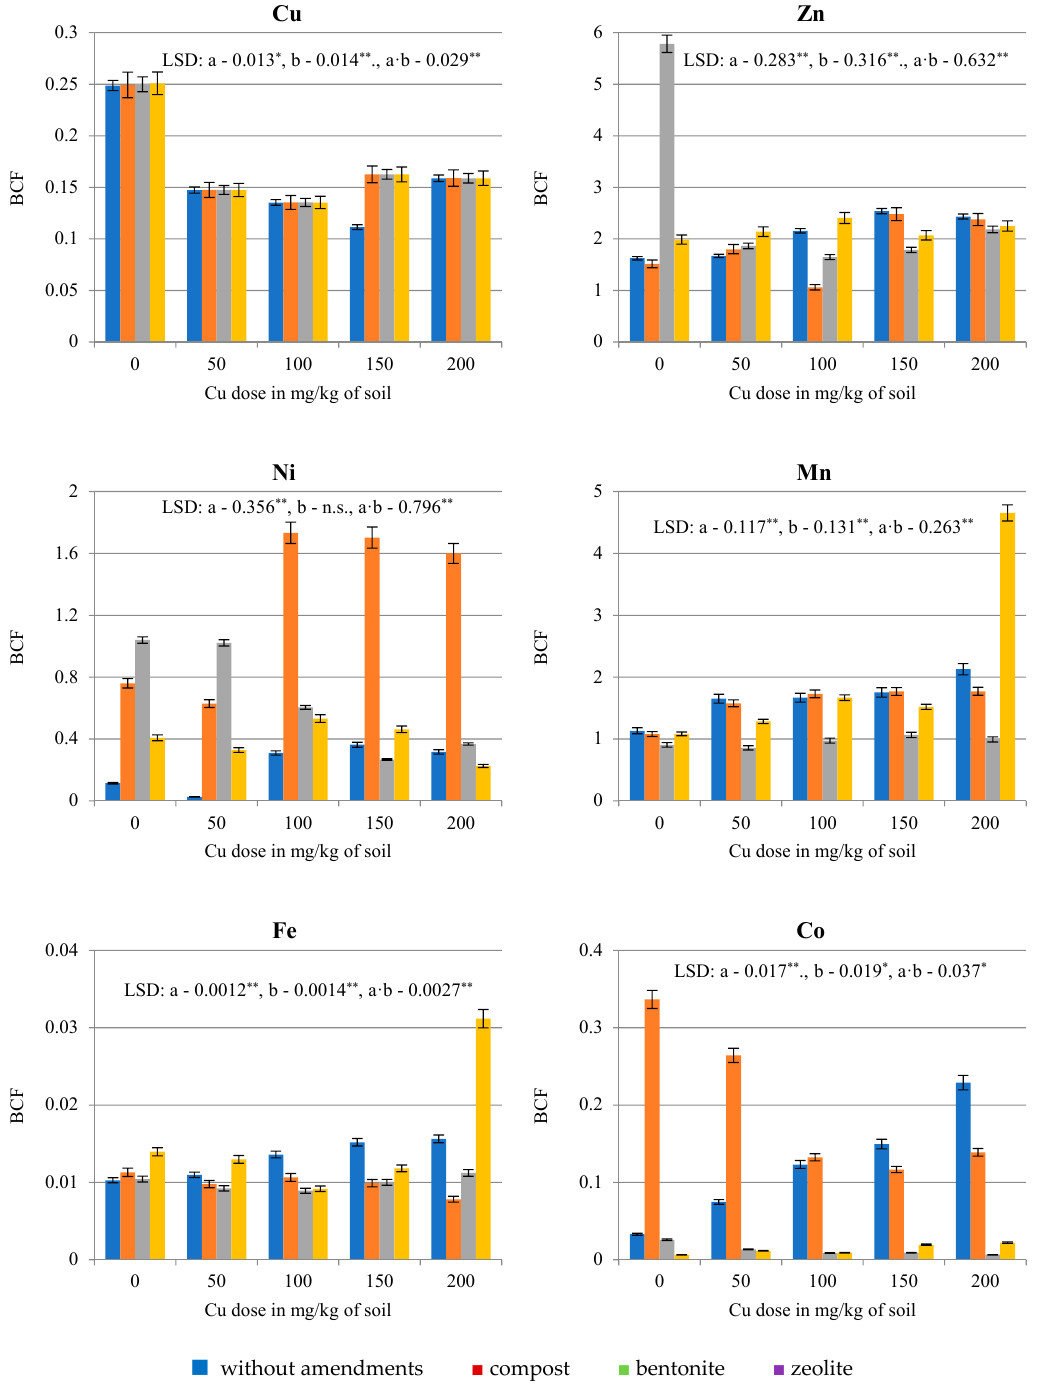
Figure 4. Bioconcentration factor (BCF) of copper (Cu), zinc (Zn), nickel (Ni), manganese (Mn), iron (Fe) and cobalt (Co) in shoots of maize ( Zea mays L.). LSD significant for: ** p ≤ 0.01, * p ≤ 0.05; n.s.—non-significant.